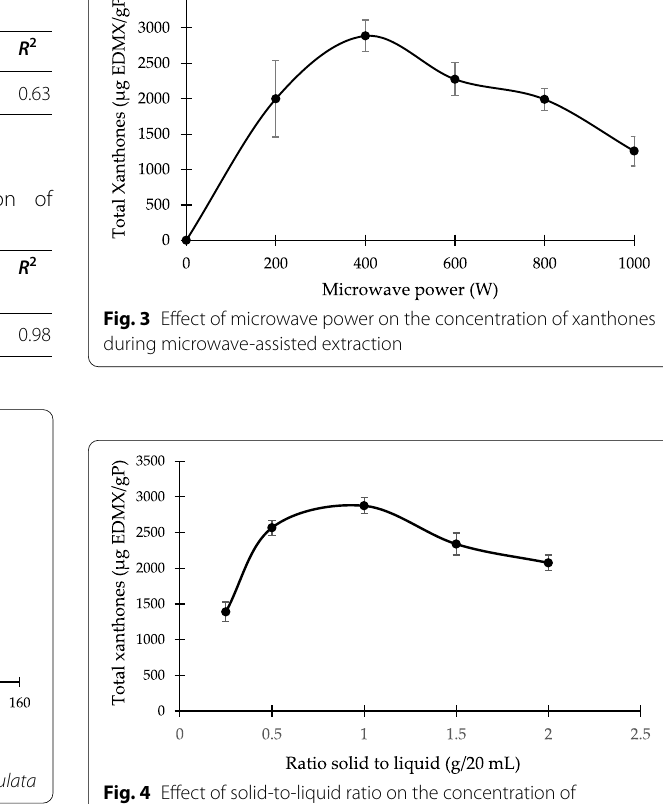
Table 1 Hervas model of microwave-assisted extraction of